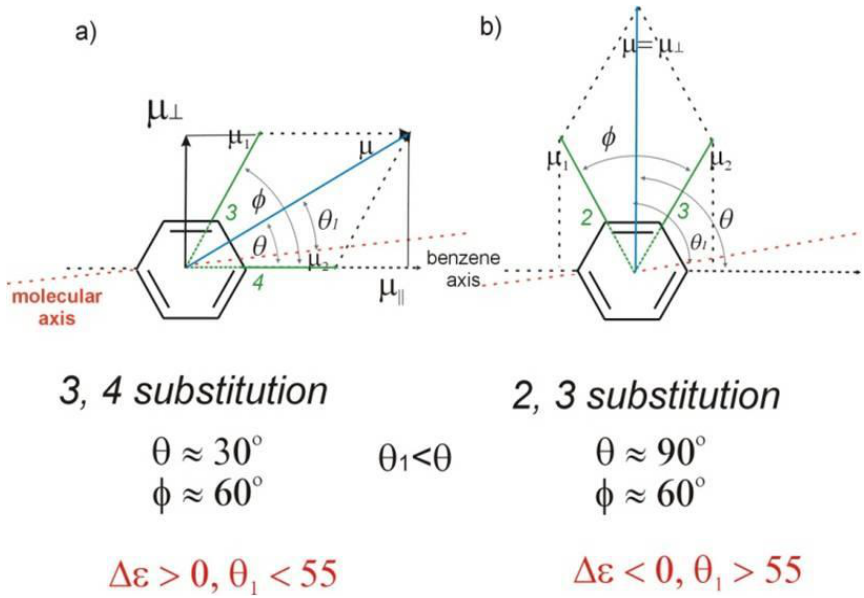
Figure 5. Benzene ring with two polar groups in position 3,4-( a ) or 2,3-( b ) and its resultant dipole moment μ and μ and components with its influence on the dielectric anisotropy ‖ of molecule